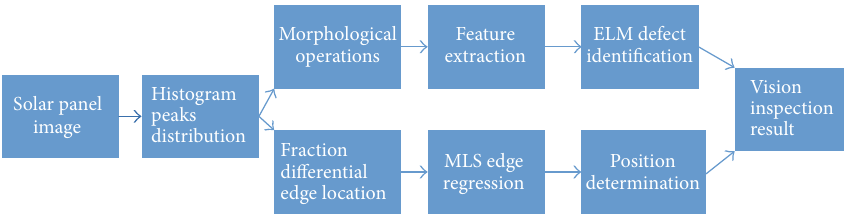
Figure 1: The proposed scheme of solder joint defect detection and solar panel position